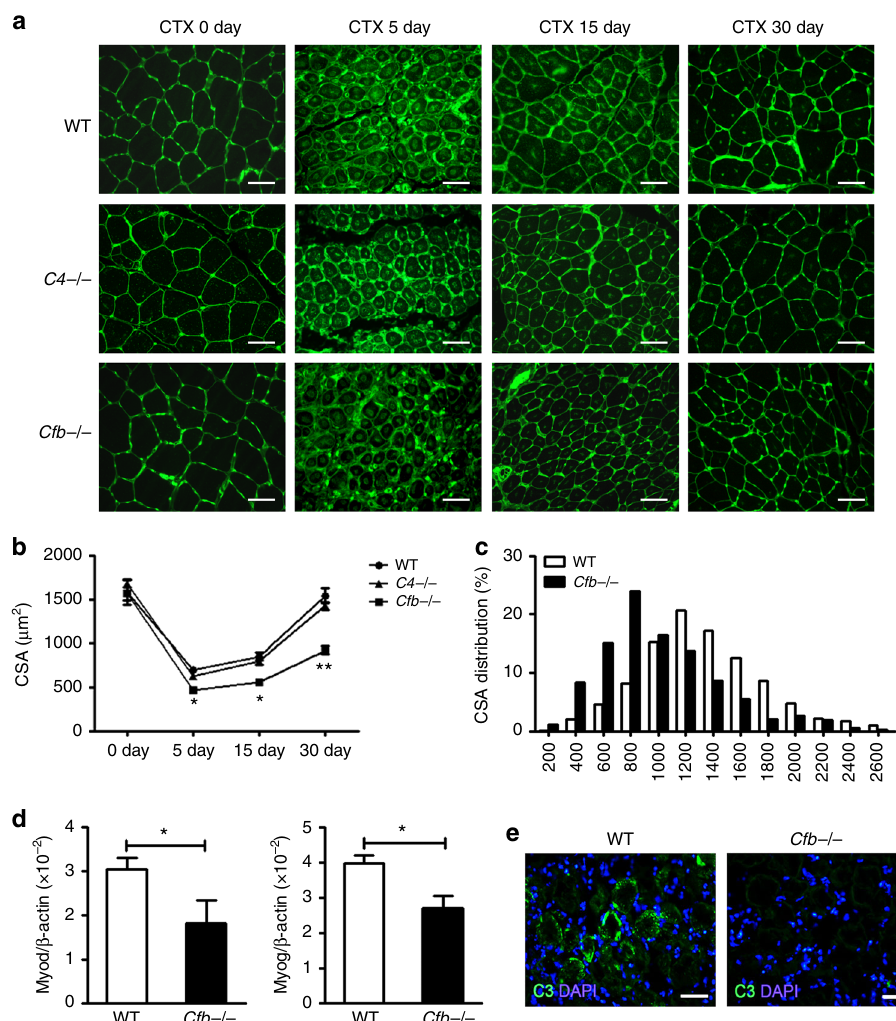
Fig. 3 The complement alternative activation is critical for muscle regeneration. a At 0, 5, 15, and 30 days after injury, muscles from WT, C4 − / − and Cfb − / − mice were immunostained with WGA (green). (Bars, 50 μ m). b The mean myo fi ber CSA in injured muscles from WT, C4 − / − and Cfb − / − mice at 0, 5, 15, and 30 days after injury were measured. ( N = 4 in per time point). c The distribution of myo fi ber sizes of WT and Cfb − / − mice at 30 days after injury was analyzed, ~250 myo fi bers of each sample. d At day 5 after injury, the mRNA expression levels of Myod and Myog in WT and Cfb − / − muscle were assessed by real-time PCR ( N = 4 in each group). e Immuno fl uorescence staining of C3b/iC3b(green) in WT and Cfb − / − muscle at day 1 after CTX-injured TA muscle, and the nuclei were counter stained with DAPI (blue). (Bars, 50 μ m). Data are expressed as the mean ± s.e.m. * P < 0.05, ** P < 0.01, unpaired t -test, mouse serum as an exogenous source of Factor B. As shown by ELISA assay (Supplementary Fig. 1c), 1 h after intravenous injection of WT mouse serum, LPS-dependent AP complement activity was restored and it lasted 8 h after serum reconstitution. Myod and Myog mRNA expression in muscles after CTX injury (Supplementary Fig. 1d) and corrected the defect in muscle regeneration and myoblast proliferation (Supplementary Fig. 1e). In addition, Sirius red staining revealed more interstitial fi brosis formation in CTX-treated Cfb − / − mouse muscle (Supplementary Fig. 2a, b). We also found that mRNA expression levels of Acta2 and Tgfb1 , genes that are associated with fi brosis formation, were signi fi cantly higher in Cfb − / − mice than in WT mice (Supple- mentary Fig. 2c), and reconstitution of Cfb − / − mice with WT mouse serum reduced Acta2 and Tgfb1 mRNA levels in the mutant mice (Supplementary Fig. 2d). Taken together, these results suggested that activation of the AP promoted muscle regeneration.